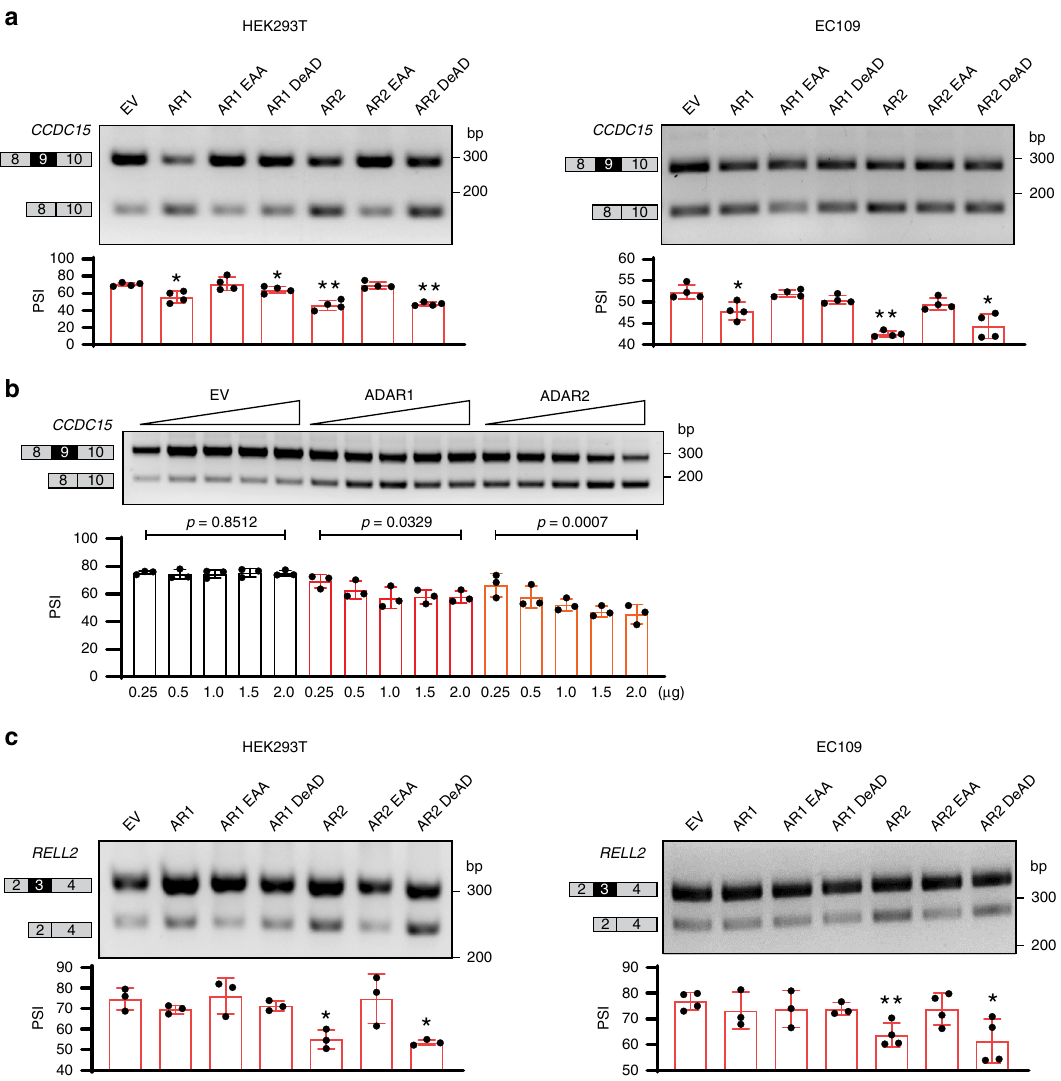
Fig. 2 ADARs repress exon inclusion editing dependently and independently. a RT-PCR analysis of CCDC15 -ex9 inclusion in HEK293T (left) and EC109 (right) cells that were transfected with the indicated wild-type ADAR1 (AR1) or ADAR2 (AR2) and different mutant (EAA and DeAD) forms of expression constructs ( n = 4 biological replicates for each). EV, empty vector. b RT-PCR analysis of CCDC15 -ex9 inclusion in HEK293T that were transfected with the indicated amount of EV, ADAR1 , or ADAR2 construct ( n = 3 biological replicates for each). Statistical signi fi cance of dose treatment is determined by linear regression. c RT-PCR analysis of RELL2 -ex3 inclusion in the same samples as described in a ( n = 3 or 4 biological replicates for each). a , c Data are presented as the mean ± S.D. of percent spliced in (PSI) values from biological replicates. Each dot represents a biological replicate. Statistical signi fi cance is determined by paired t -test (* P < 0.05; ** P < 0.01). Source data are provided as a Source Data fi